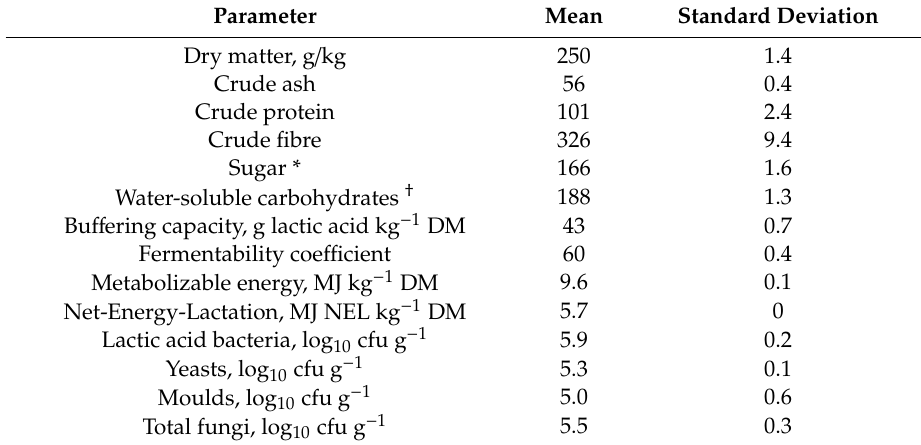
Table 2. Composition of wilted forage before additive application ( n = 3, data given in g kg − 1 DM unless stated